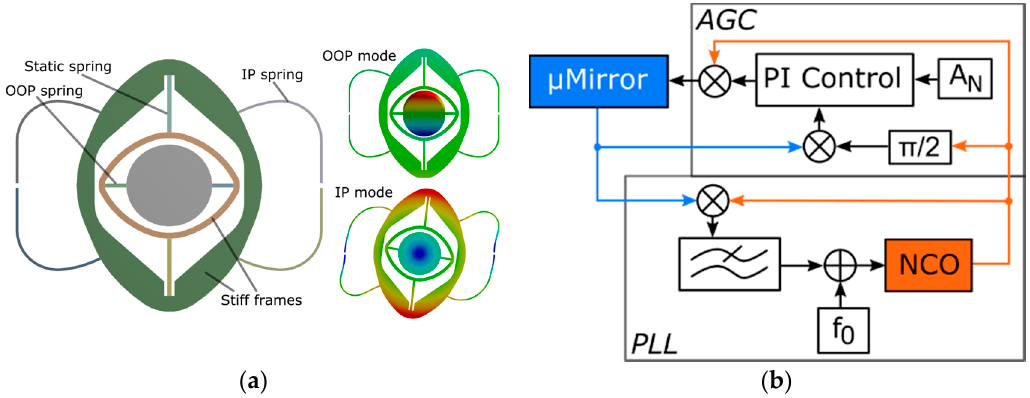
Figure 2. ( a ) CAD model of the developed reference design for a gyroscopically actuated 2D micromirror and shapes of the resonant modes of interest; ( b ) Schematic representation of the PLL- AGC based control algorithm implemented in Ansys